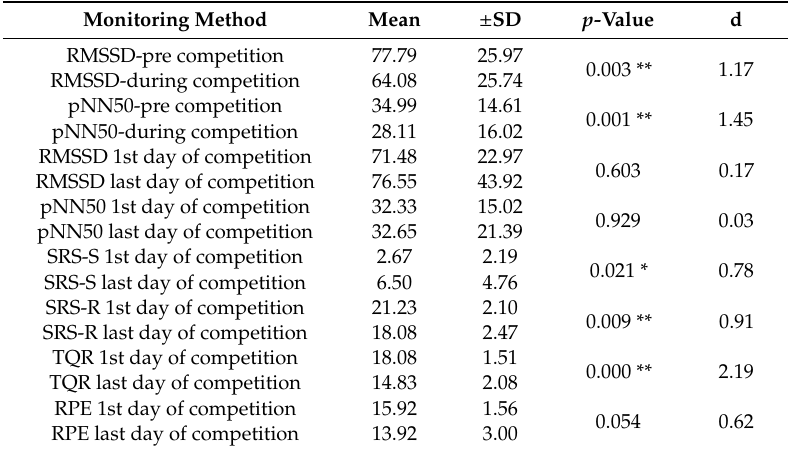
Table 2. Di ff erences between objective and subjective monitoring methods during competition. Results are presented as mean ± SD (95% CI).